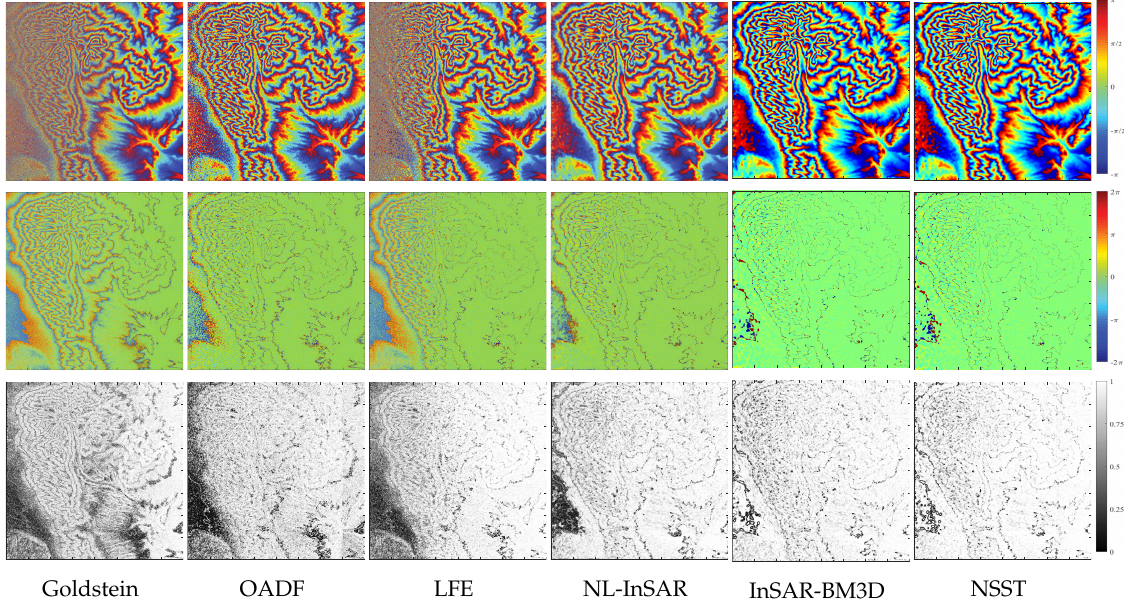
Figure 12. The filter results of the interferogram generated by a complex topography with variable coherence ( top ), the residuals graph ( middle ) and the GMS map ( bottom